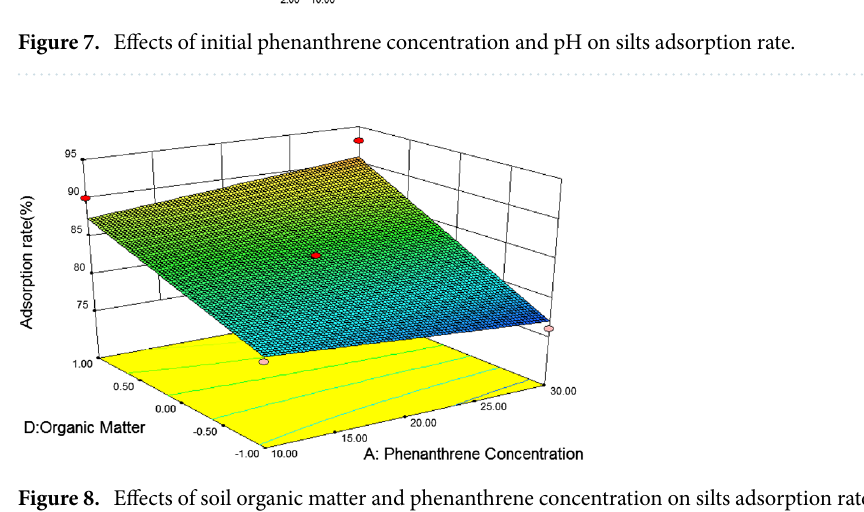
Figure 8. Effects of soil organic matter and phenanthrene concentration on silts adsorption